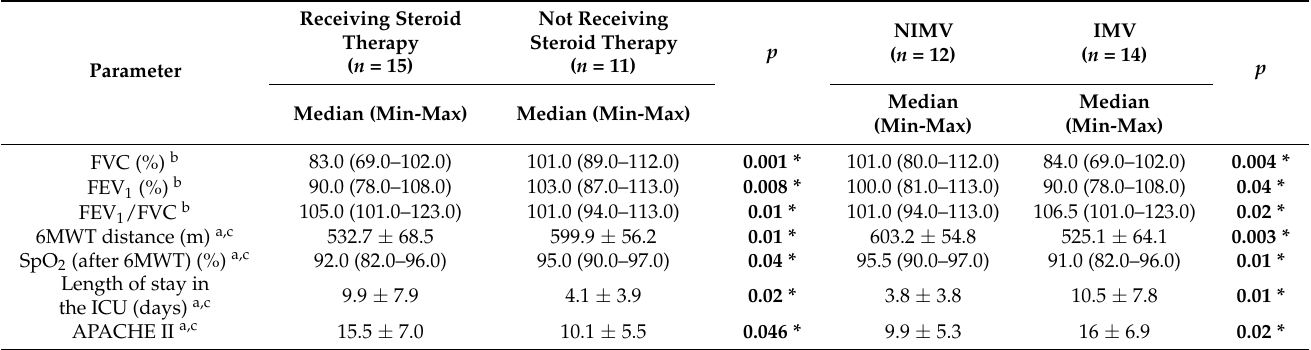
Table 3. Comparison of respiratory function and functional capacity of individuals with COVID-19 between those who received and did not receive steroid therapy and those who received NIMV and